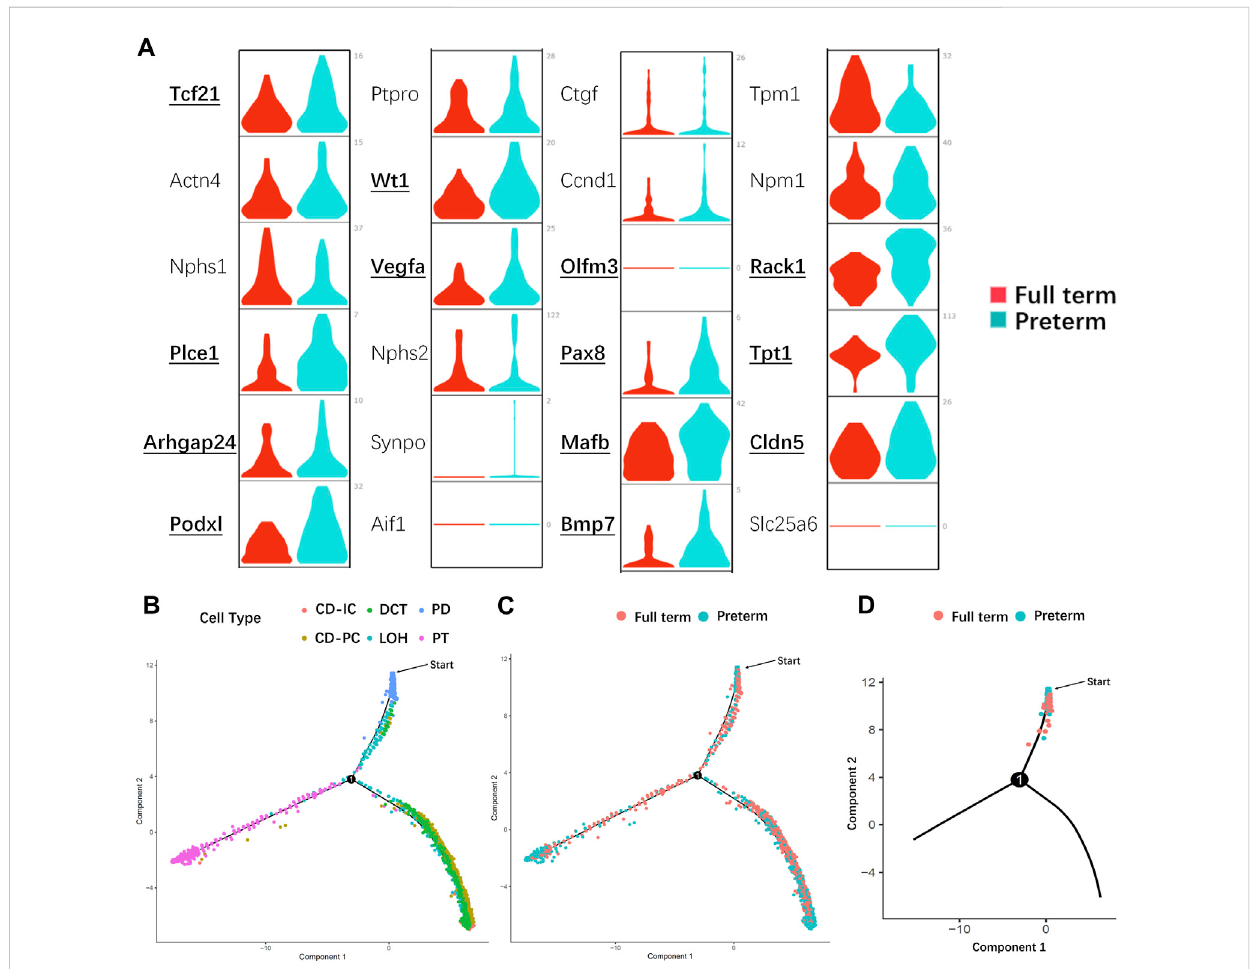
FIGURE 6 Preterm birth accelerated the maturation of PDs. (A) Violin plots showing the expression of known PD- and PD precursor-speci fi c genes in the preterm (postnatal day 2) and full-term groups (postnatal day 0). X-axis: different groups, the red color represents the full-term group, and teal blue representsthepretermgroup;y-axis:geneexpressionvalue.Boldtextindicatesthatthereisasigni fi cantdifferenceinthatgenebetweenthetwogroups. Most PD- and PD precursor-speci fi c genes were highly expressed in PDs from preterm rats, indicating that these PDs were more mature than PDs fromfull-termrats. (B) Pseudotimetrajectoryofthemajorkidneycelltypes(CD-IC,CD-PC,DCT,LOH,PD,andPT).Differentcolorsindicatedifferentcell types. PDs(blue) werethe fi rst cell typeamong theprogenitorsto beinduced. (C) Pseudotime trajectory ofdifferentgroups ofkidney cells. The red color represents the full-term group (postnatal day 0), and teal blue represents the preterm group (postnatal day 2). (D) In the PD split monocle pseudotime plot, PDs from preterm rats (postnatal day 2) (teal blue) were present earlier on the pseudotime path than PDs from full-term rats (postnatal day 0) (red). (Note: The starting points in (B – D) were applied to identify which cell population appear earlier from differentiation instead of starting of nephron progenitor cells. Abbreviations: LOH: loop of Henle, DCT: distal convoluted tubule, CD-PC: principal cell of the collecting duct, CD-IC: intercalated cell of the collecting duct, PT: proximal